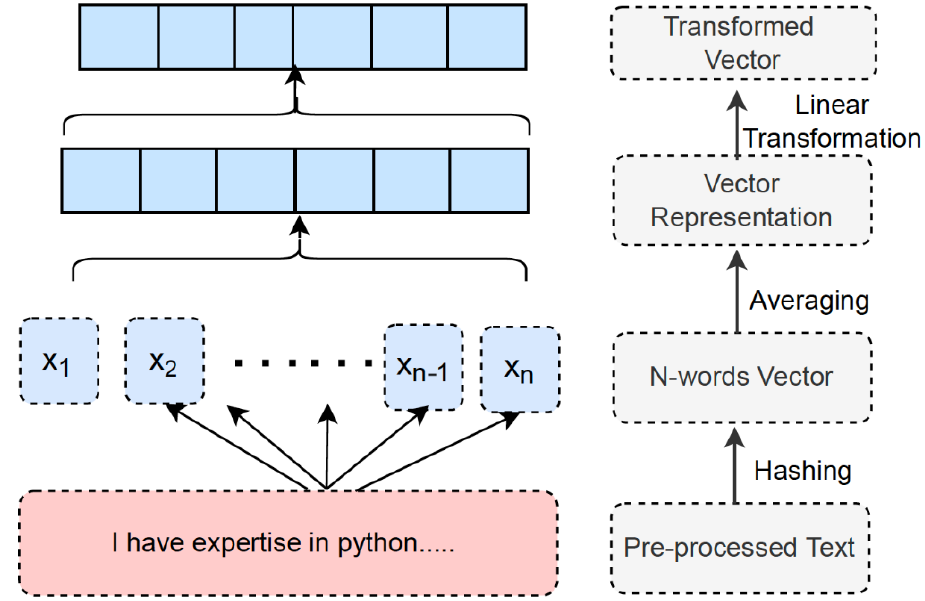
Figure 2. Architecture of fastText embedding.